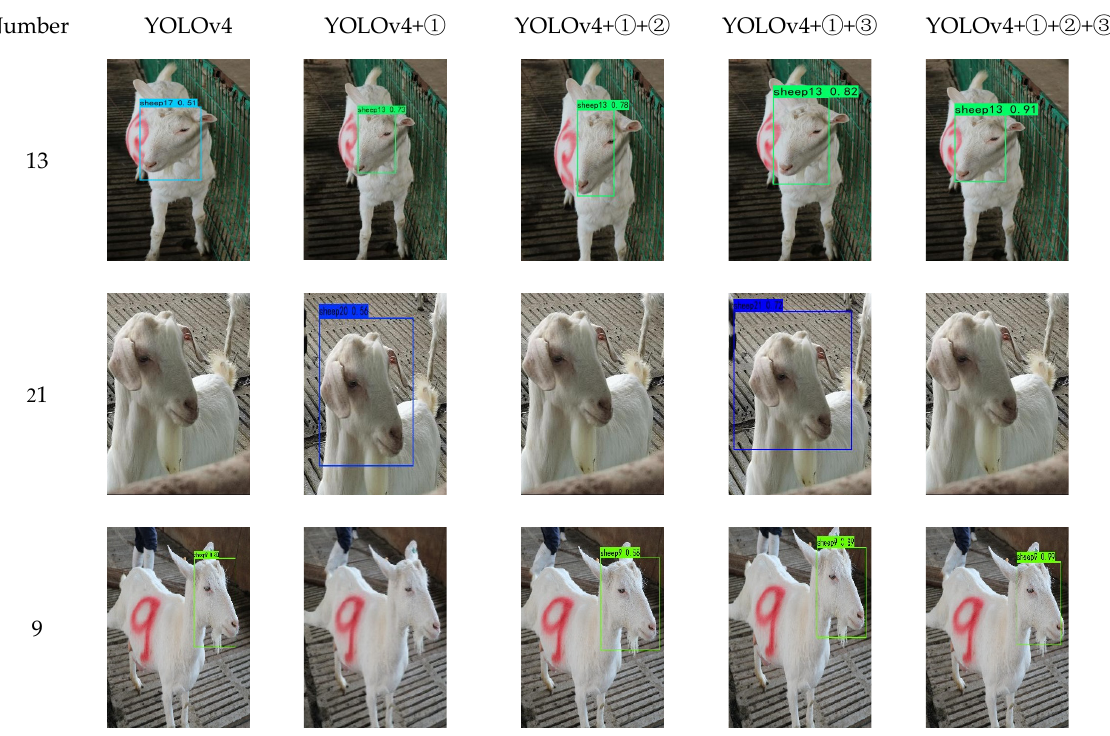
Figure 9. Side-face-recognition results of different models (IOU = 0.5).